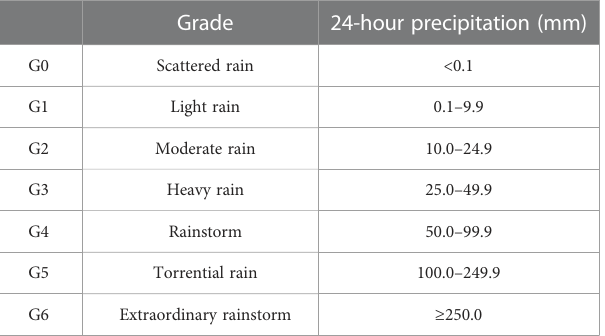
TABLE 3 Grade of precipitation over a 24-hour period.